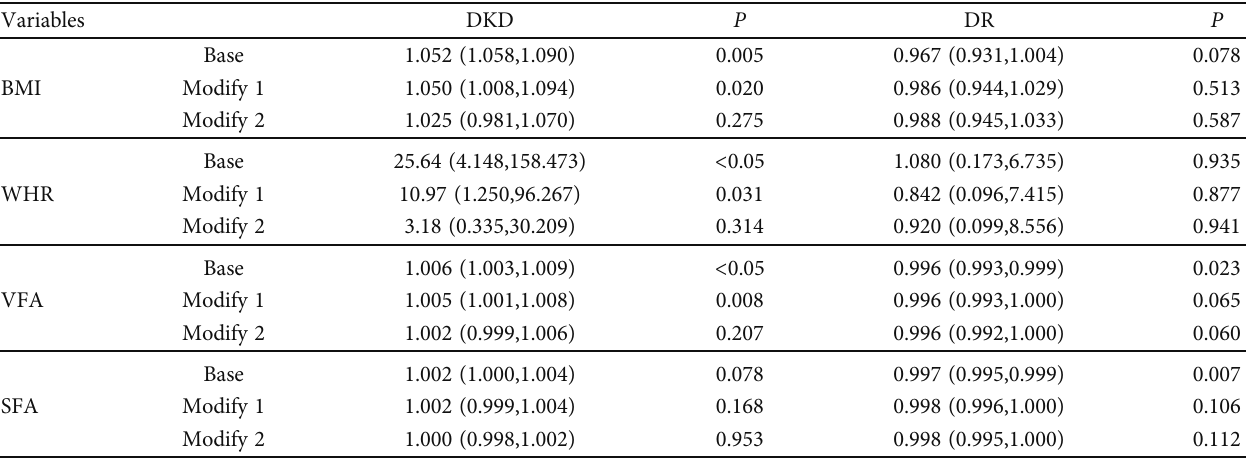
Table 2: Associations between obesity indices and the prevalence of DKD or DR in the logistic regression models. Variables